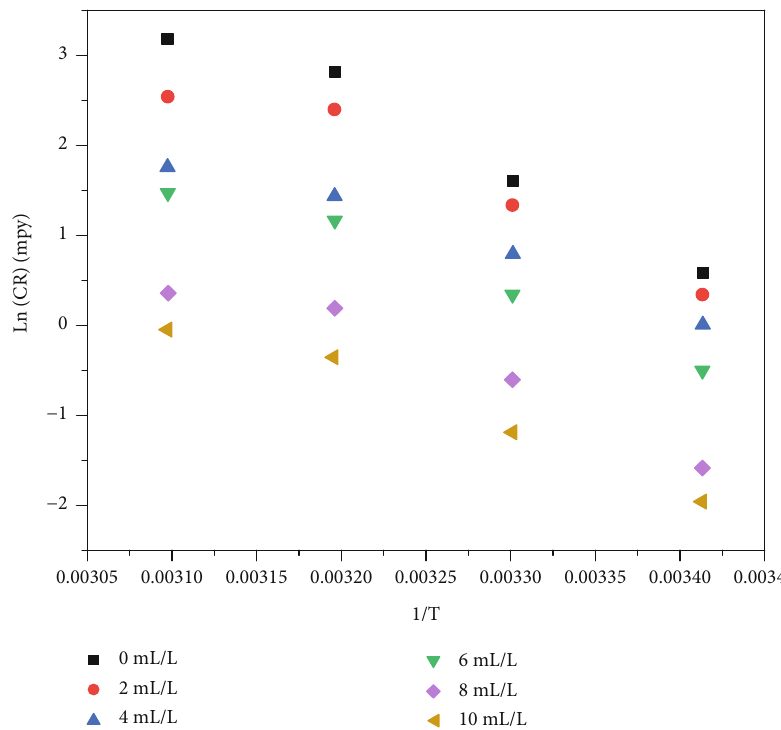
Figure 4: Arrhenius plot of aluminium corrosion in 1 M hydrochloric acid, including varying temperatures and concentrations of PDL extract.